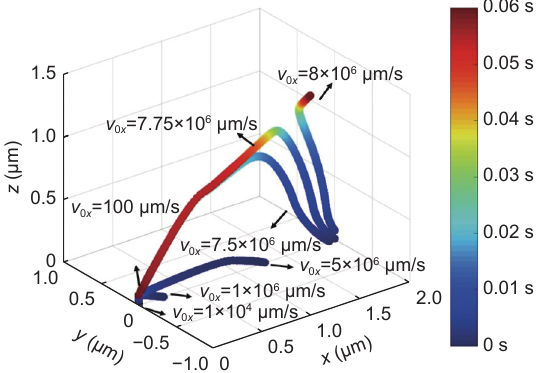
Fig. 6 | The 3D trajectories of the micro-sphere at different ini- tial velocities in the x -axis in the optical tweezers with v 0 x